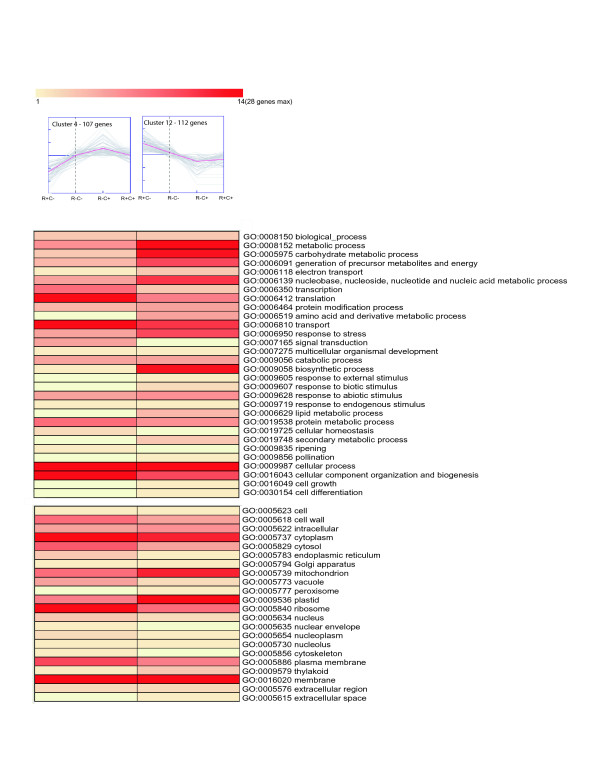
Gene clusters with inverse expression profiles exclusively in ripened fruits. Cluster 4 (left) contains 107 genes that have reduced expression exclusively in juicy, mature fruits (E2: R+, C-), whereas cluster 12 (right) contains 112 genes with increased expression exclusively in these same fruits. The Gene Ontology annotations of the genes in these clusters are represented below each cluster. The number of genes associated with each GO term is represented by the color of the bars, as depicted in the scale presented in this figure. The dashed line indicates non-ripe fruits, E1 (R-, C-). To the left of the dashed line is the expression levels for ripe, juicy fruits, E2 (R+, C-). To the right of the dashed line are E3 (R-, C+) and E4 (R+, C+) fruits, non-ripe and ripe fruits that have undergone long-term cold storage, respectively. E4 (R+, C+) fruits are wooly. GO annotations correspond to the parental plant GO Slim terms.